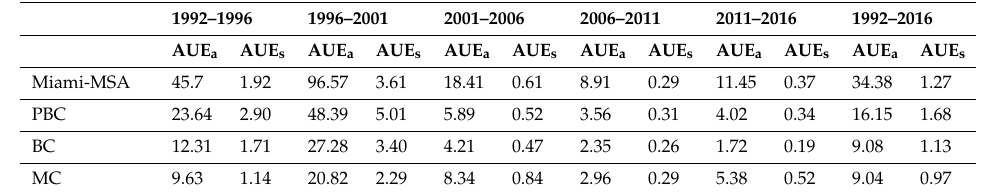
Table 4. Annual urban expansion rate (AUE a ) (km 2 year − 1 ) and AUE s (%) in Miami MSA and three counties during